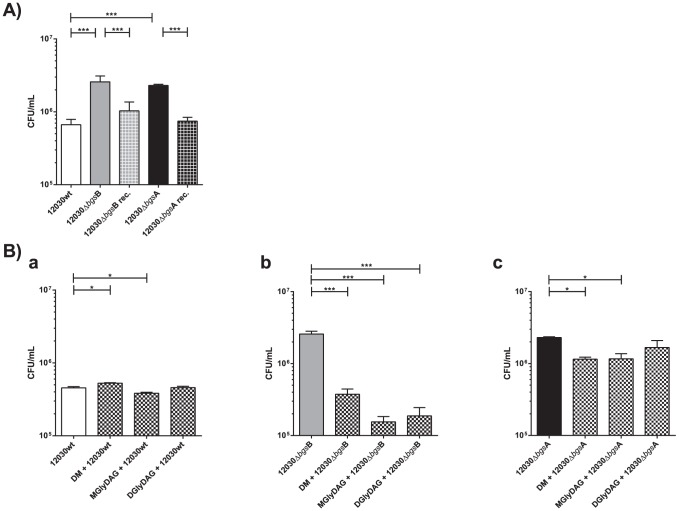
Attachment to T24 cells.(A) E. faecalis 12030 wild-type (white bar), E. faecalis 12030ΔbgsB mutant (grey bar), reconstituted E. faecalis 12030ΔbgsB mutant (grey squared bar), E. faecalis 12030ΔbgsA mutant (black bar) and reconstituted E. faecalis 12030ΔbgsA mutant (black squared bar) were tested for their ability to bind to T24 cells. T24 cells were incubated for 2 hours with bacteria grown to mid-log phase at a bacteria-to-cell ratio of 100∶1. Total cell-associated bacteria include surface-adherent and intracellular bacteria. Both mutants showed clearly increased binding compared to the wild-type strain and the reconstituted mutant showed reduce binding compared to the mutants. Data represent the means with standard error of the mean (SEM). B) Inhibition of bacterial attachment to T24 cells using glycolipids. E. faecalis 12030 wild-type (a, white bar), E. faecalis 12030ΔbgsB mutant (b, grey bar) and E. faecalis 12030ΔbgsA mutant (c, black bar) were tested. T24 cells were incubated with glycolipids (M: MGlyDAG, D: DGlyDAG and DM: mixture of MGlyDAG and DGlyDAG) for 30 min before addition of bacteria to assess attachment. Each glycolipid alone and the mixture of both significantly reduced bacterial binding using ANOVA with Bonferroni's multiple comparison test. For all inhibitions using glycolipids, differences were statistically significant at p<0.001. Bars represent average ± S.E.